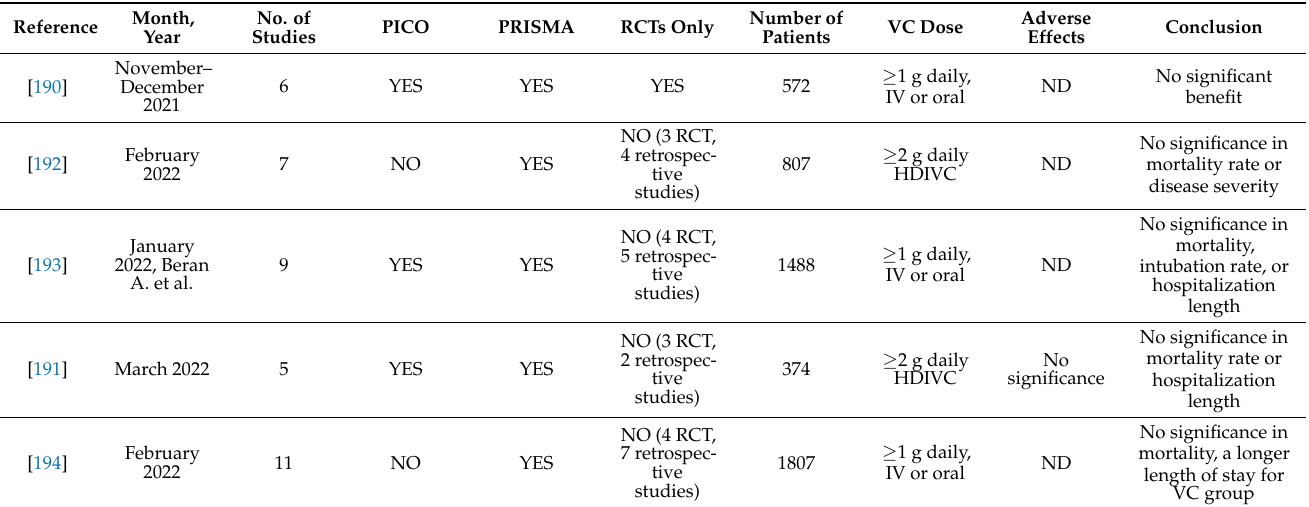
Table 3. Meta-analyses conducted on the topic of VC use in COVID-19